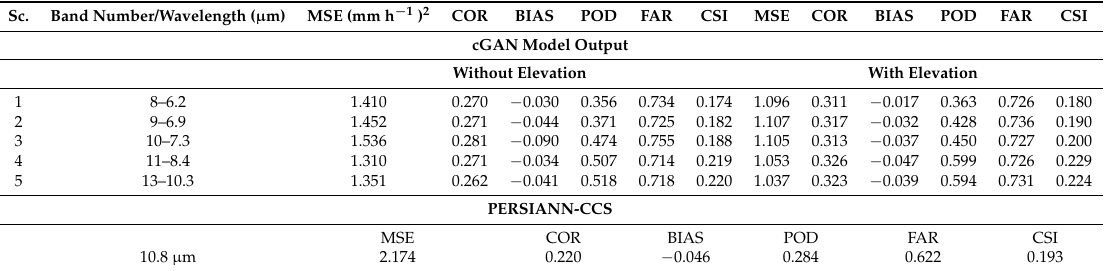
Table 5. Statistical evaluation metrics values for different scenarios using single spectral